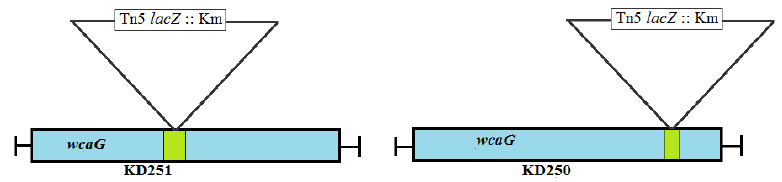
Figure 4. Schematic of transposon insertion in the mutants. Insertion point of transposon lacZ 1 Km (2.36kb) in wcaG of both KD250 and KD251.